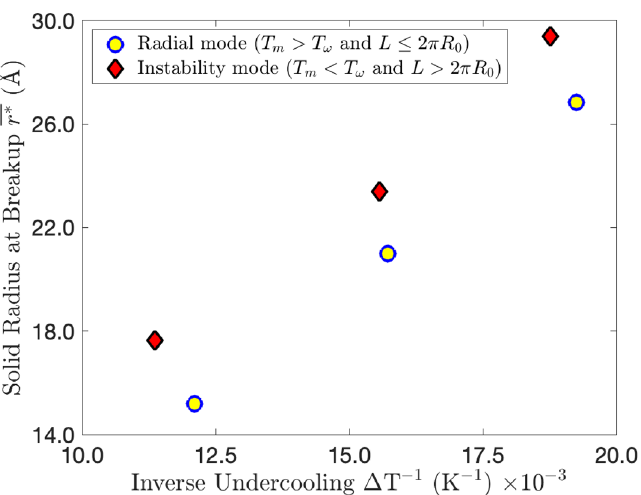
1 Figure 5. Values of r ∗ obtained from simulation against (cid:31) T − . Yellow circles are for r ∗ when L ≤ 2 π R 0 , and red diamond points represent r ∗ and (cid:31) T for when L > 2 π R 0 . Yellow circles indicate when the radial mode is the preferred melting mechanism, and red diamonds indicate where the instability mode is preferred. The first two points (bottom left) are for wires where R 0 ≈ 22 Å the middle two are for R 0 ≈ 30 Å, and the last two are for R 0 ≈ 38 Å. We assume yellow and red points represent the bulk and instability melting temperatures, T m and T ω ,